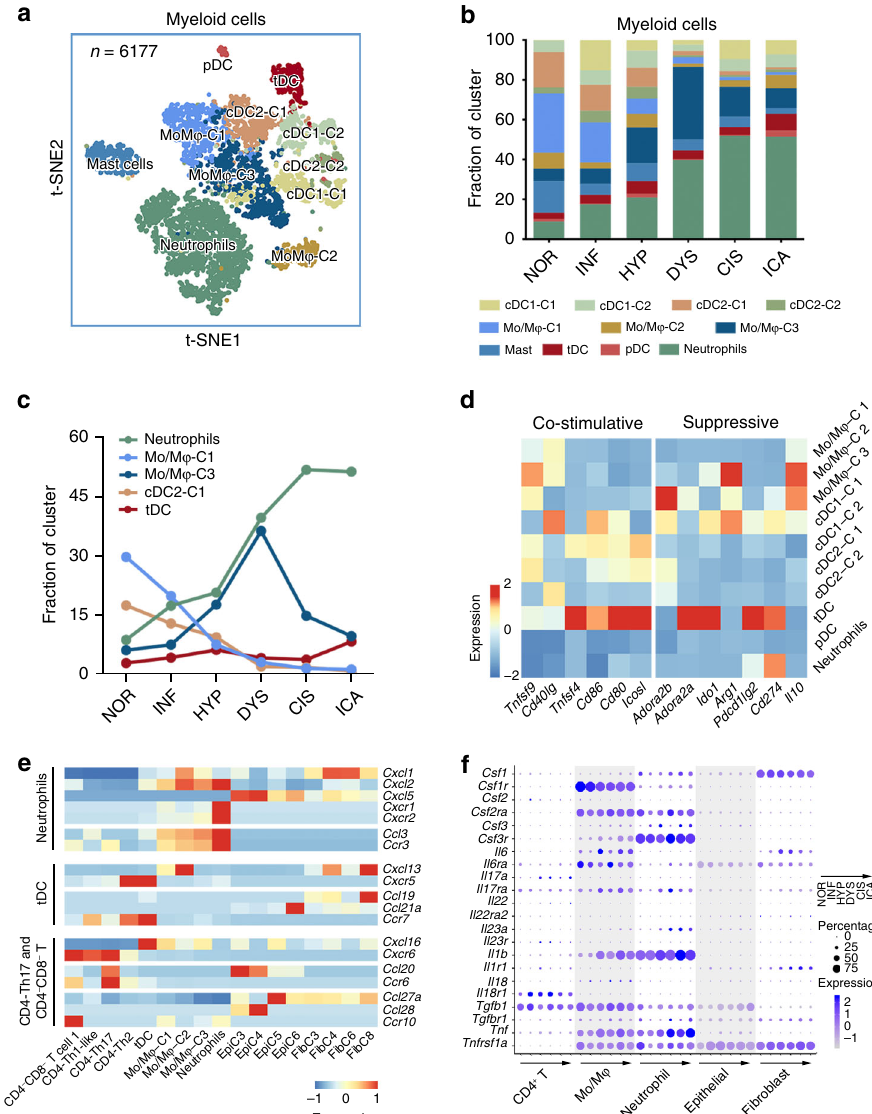
Fig. 6 Compositional changes of myeloid cells and their interactions with other cells. a tSNE plots of 6177 myeloid cells, colored by cluster. b Histogram showing myeloid cells composition across the six pathological stages. Color indicates cluster designated in a . c Line chart displaying changing trend of the fi ve selected cluster proportions across the six pathological stages. d Heatmap showing scale normalized expression of the immune co-stimulation (left panel) or suppression (right panel) genes in the 11 clusters of myeloid cells. e Heatmap showing scale normalized expression of selected Ccl and Cxcl chemokines, and their corresponding receptors in representative clusters of epithelial cells, fi broblasts, myeloid cells, and T cells. f Bubble plot showing scale normalized expression of the selected genes along tumorigenesis process in various cell types. Size of dots represents percentage of cells expressing corresponding genes across pathological